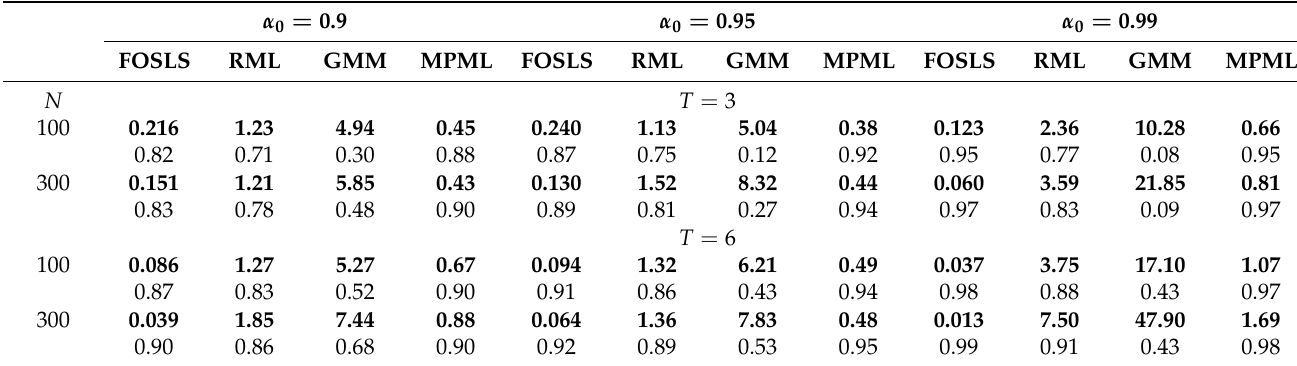
Table 3. The RMSE of FOSLS and relative RMSE (bold font) of all other estimators, and their Mean (regular font) for nonnormal near unit root